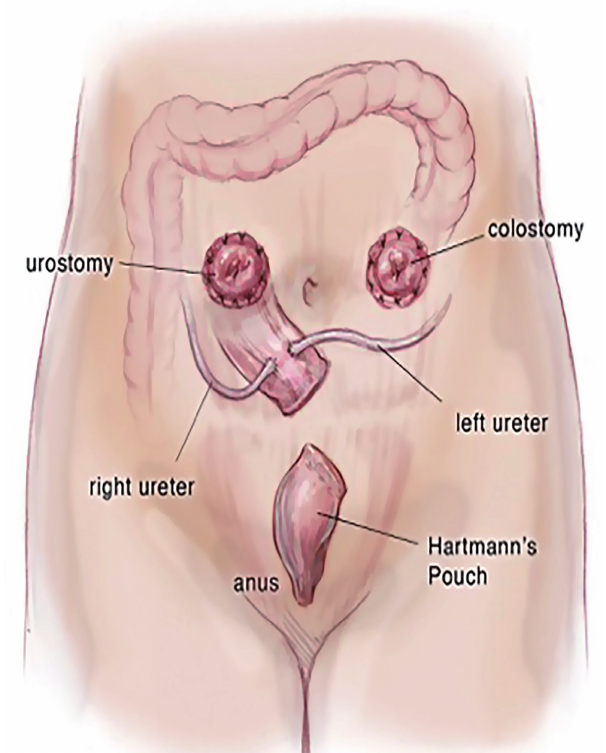
Figure 5 - Final urinary and bowel